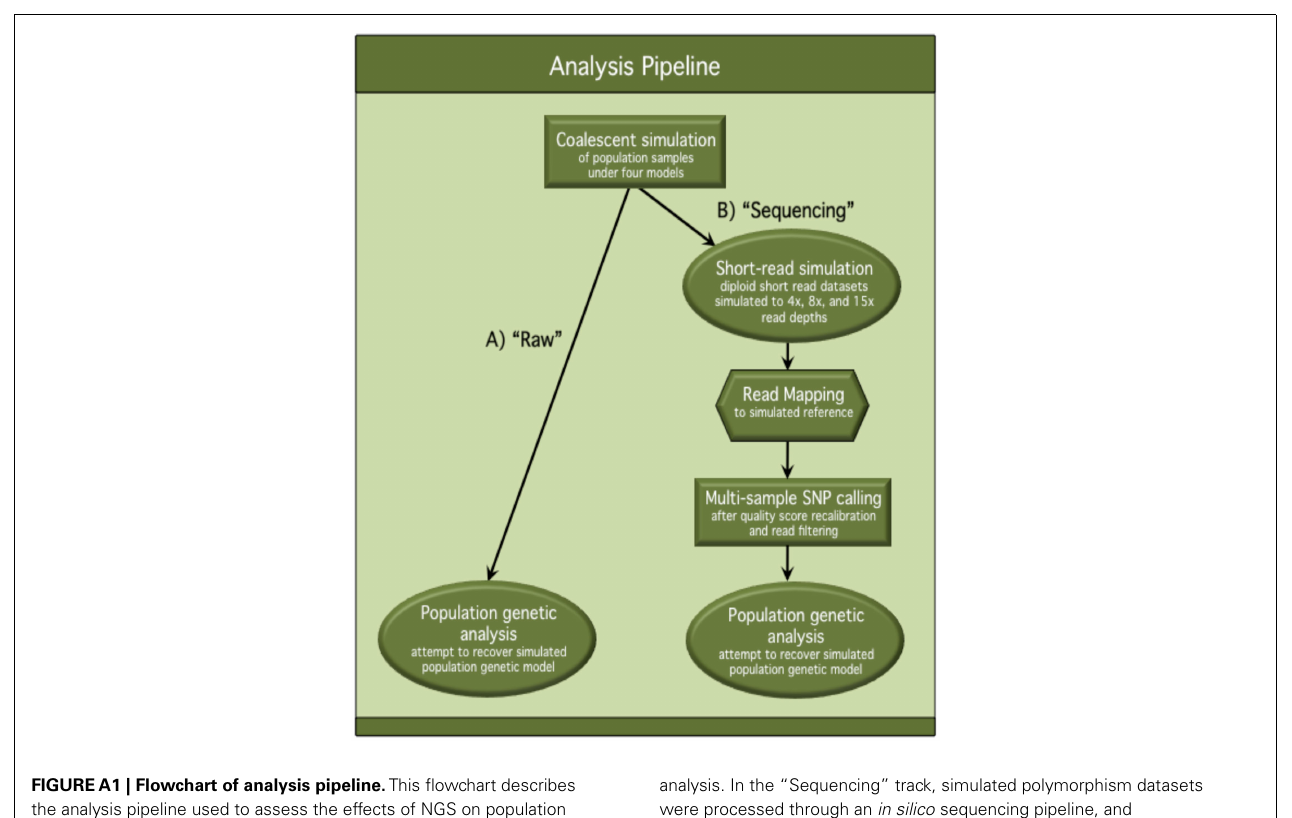
FIGUREA1 | Flowchart of analysis pipeline. This flowchart describes the analysis pipeline used to assess the effects of NGS on population genetic inference and hypothesis testing. Population samples were simulated under four population genetic models and processed through both (A) the “Raw” track of the pipeline and (B) the “Sequencing” track of the pipeline. In the “Raw” track, unmodified, simulated polymorphism datasets were used for population genetic